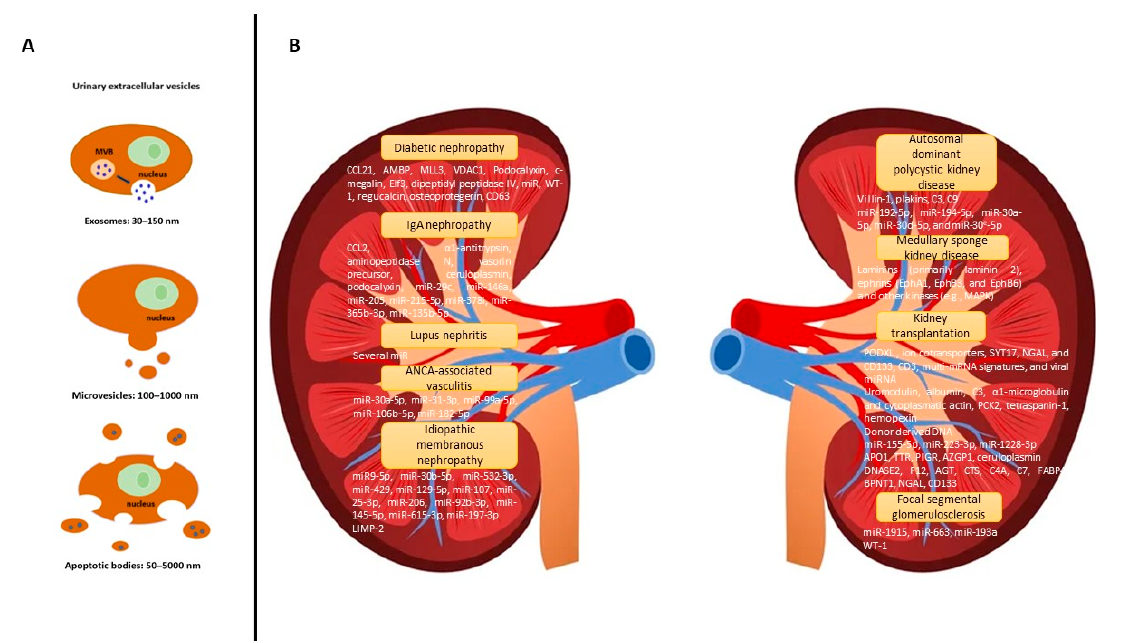
Figure 1. ( A ) The classification of extracellular urinary vesicles. Abbreviation: MVB: multivesicular bodies. ( B ) The potential value of urinary extracellular vesicles in chronic kidney diseases.